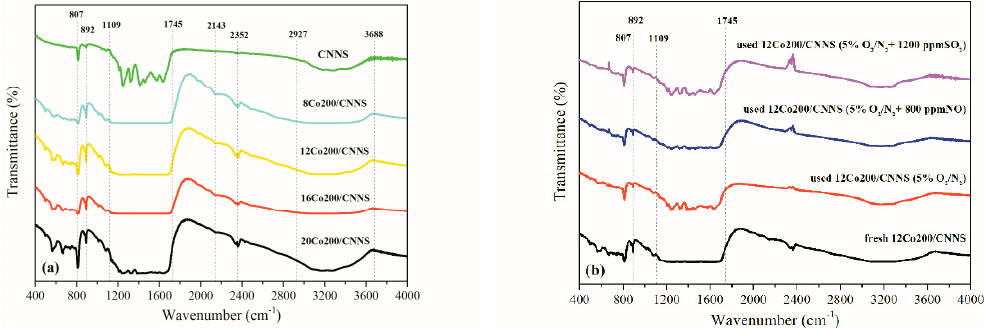
/ CNNS; ( b ) fresh and spent 12Co